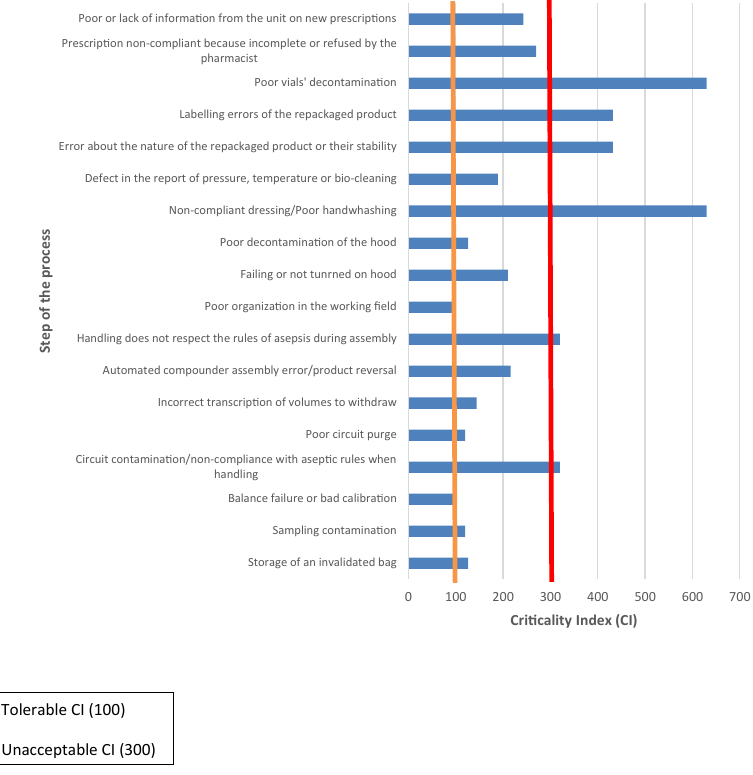
Figure 2: Failure modes for which the criticality index is greater than